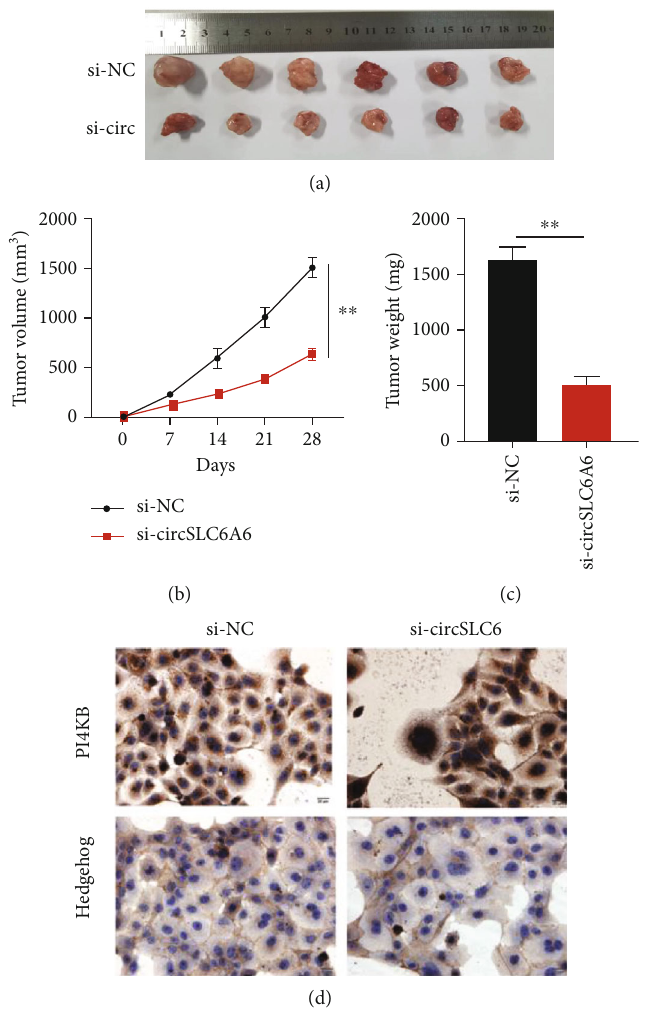
Figure 6: Silencing circSLC6A6 inhibits the growth of tumors in vivo. (a) The image of xenograft tumors was shown. (b) Tumor volumes were recorded every 7 days. (c) Tumor weights were recorded. (d) The PI4KB and hedgehog expressions were explored in EC tumor tissues by IHC ( ∗∗ p < 0 : 01